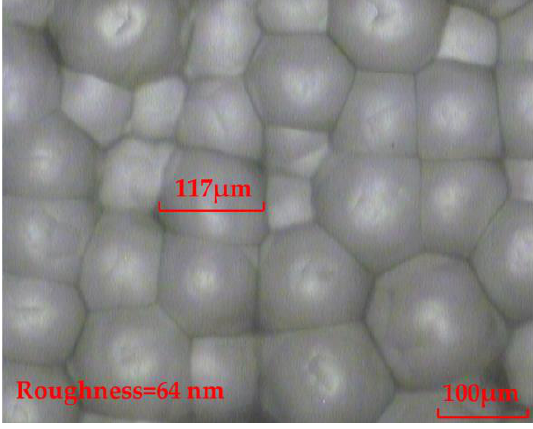
Figure 3. The rMLA fabricated by the H 2 SO 4 chemical etching solution.